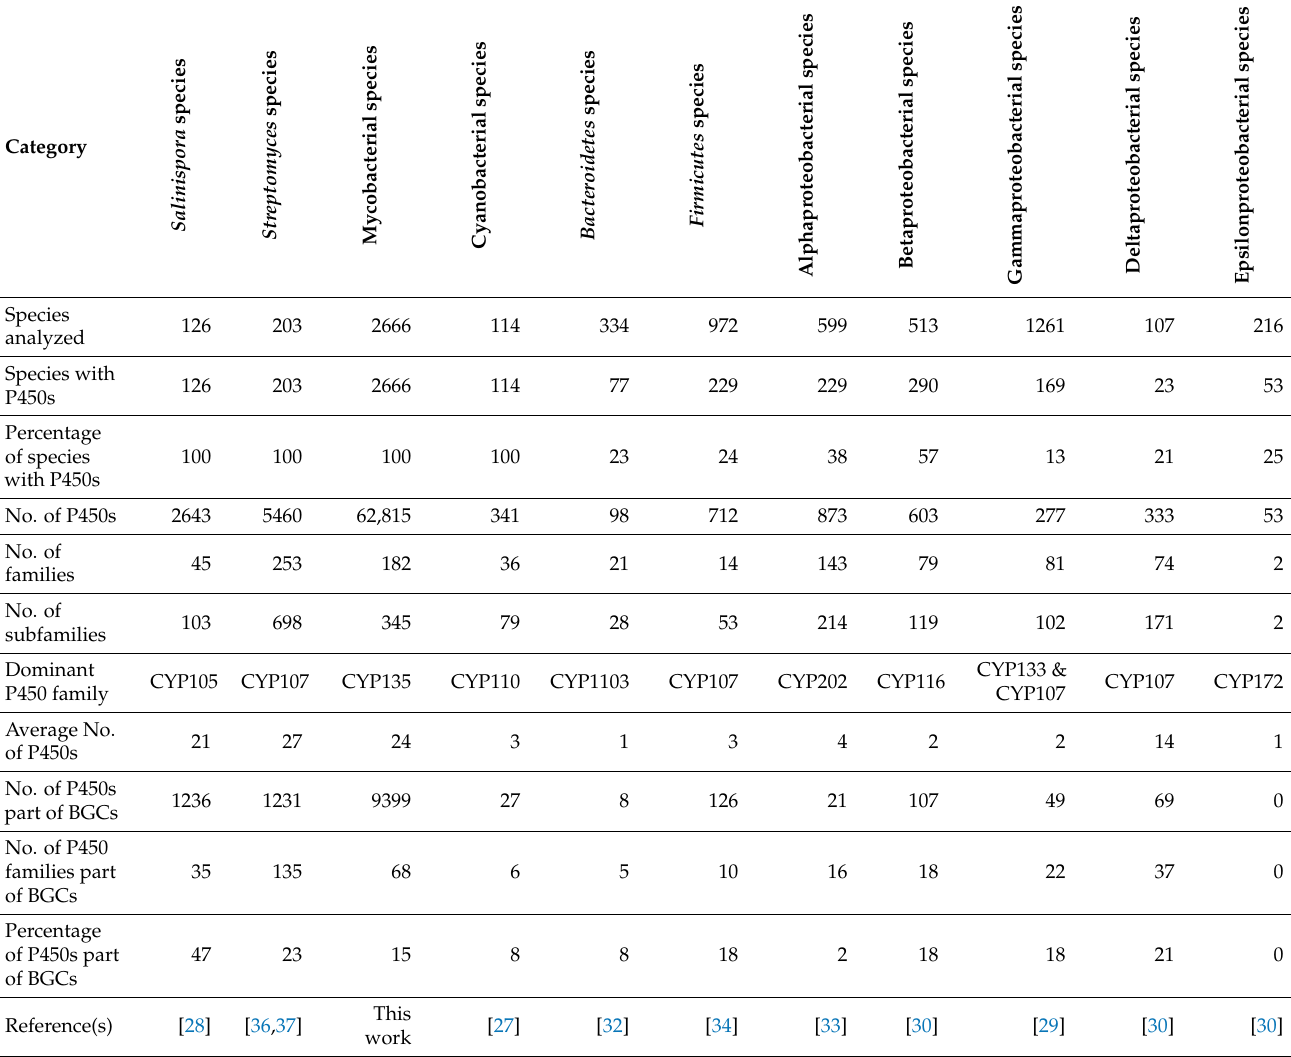
Table 1. Comparative analysis of key features of P450s and their association with secondary metabolism in different bacterial species. Abbreviation: No., number of; BGCs: biosynthetic gene clusters.